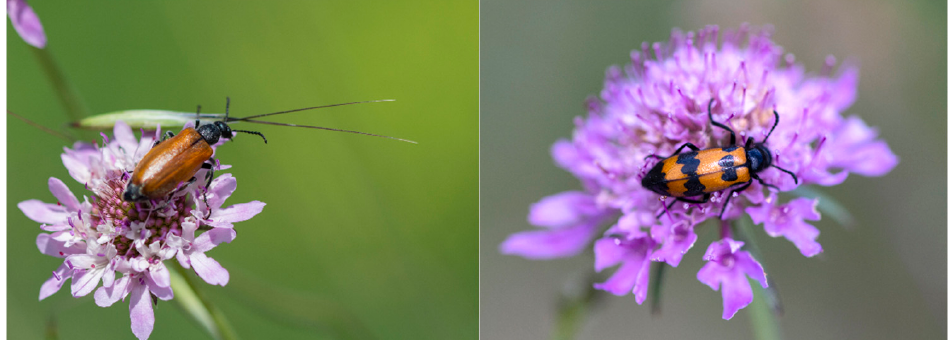
Figure 1. Habitus of the species Lydus trimaculatus , ( left ) and Mylabris variabilis ( right ). Both species belong to the subfamily Meloinae. L. trimaculatus belongs to the tribe Lyttini and M. variabilis belongs to the tribe Mylabrini. Adult specimens are depicted feeding on flowers since both species are phytophagous and polyphagous.